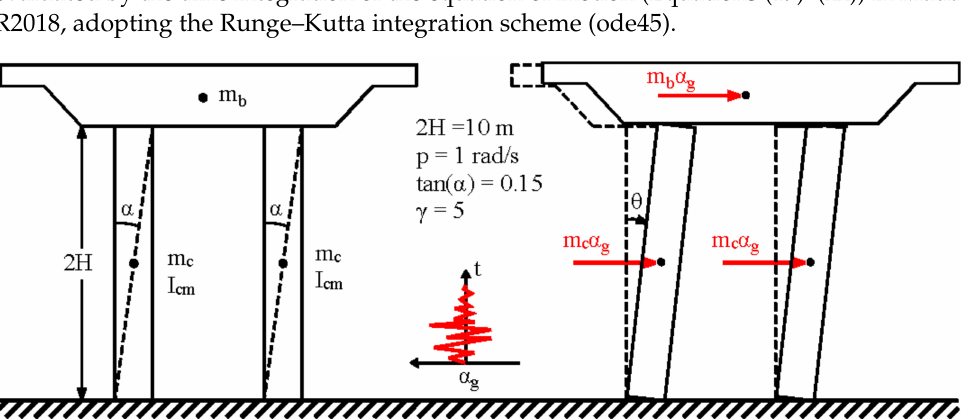
Figure 1. Examined rocking